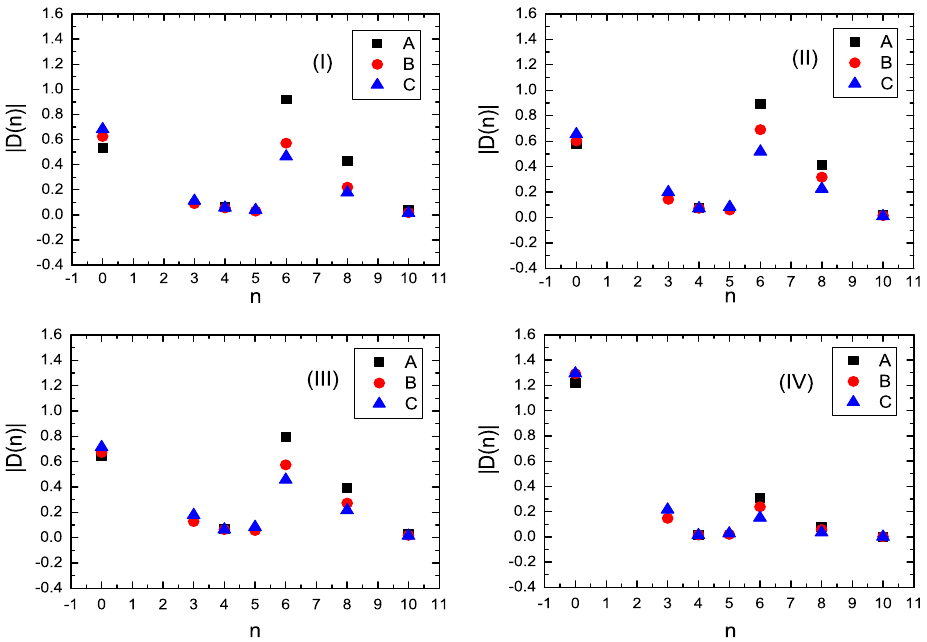
Fig. 1 The absolute contributions of the vacuum condensates of dimension n for central values of the input parameters, where the ( I )–( IV ) denote the tetraquark states with J P = 0 + , 1 + , 2 + and 1 − respectively, A , B and C denote the quark constituents cc ¯ u ¯ d , cc ¯ u ¯ s and cc ¯ s ¯ s respectively Table 1 The Borel parameters (Borel windows), continuum threshold parameters, optimal energy scales, pole contributions, masses and pole residues for the doubly charmed tetraquark states √ T 2 ( GeV 2 ) s 0 ( GeV )